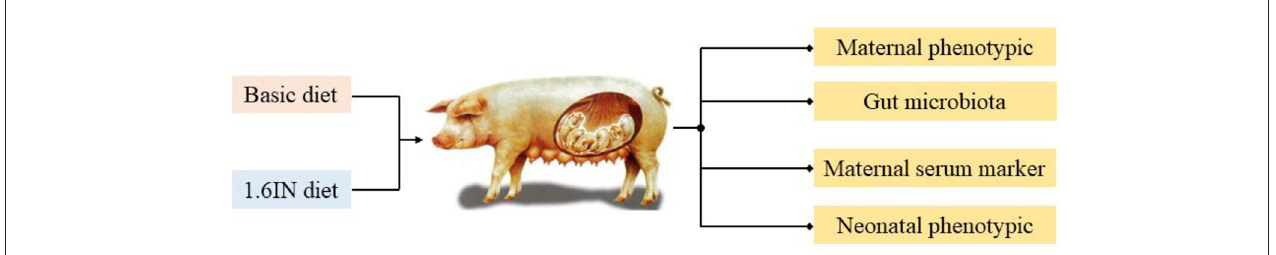
FIGURE 1 | Experimental design of this